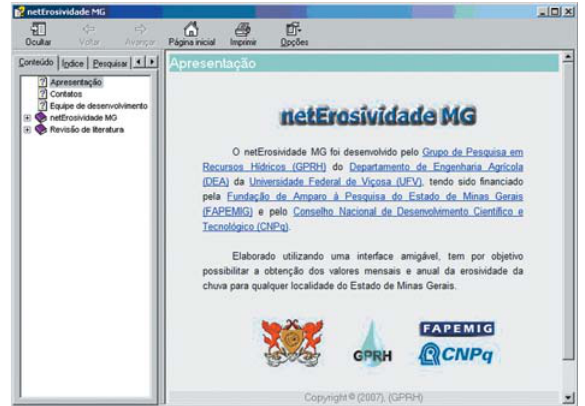
Figura 5. Sistema de ajuda do NetErosividade MG